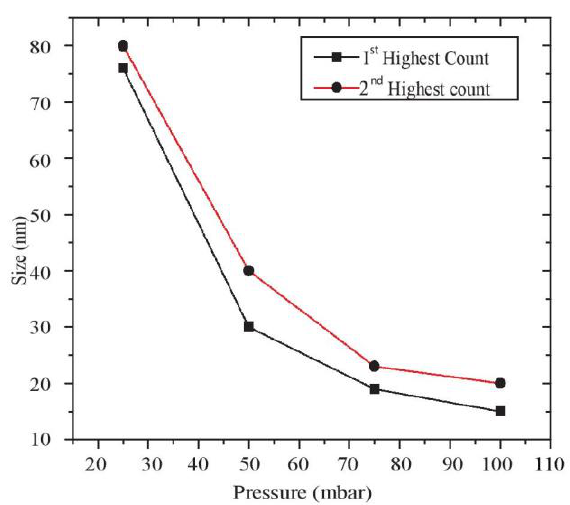
Figure 8. Nanoclusters formed at different pressures. The data shows the highest concentration of the specified sized particles quantified from high-resolution (first-highest count and second-highest count in square and circular, respectively) AFM scans shown in Figures 4, 5, 6, and 7.